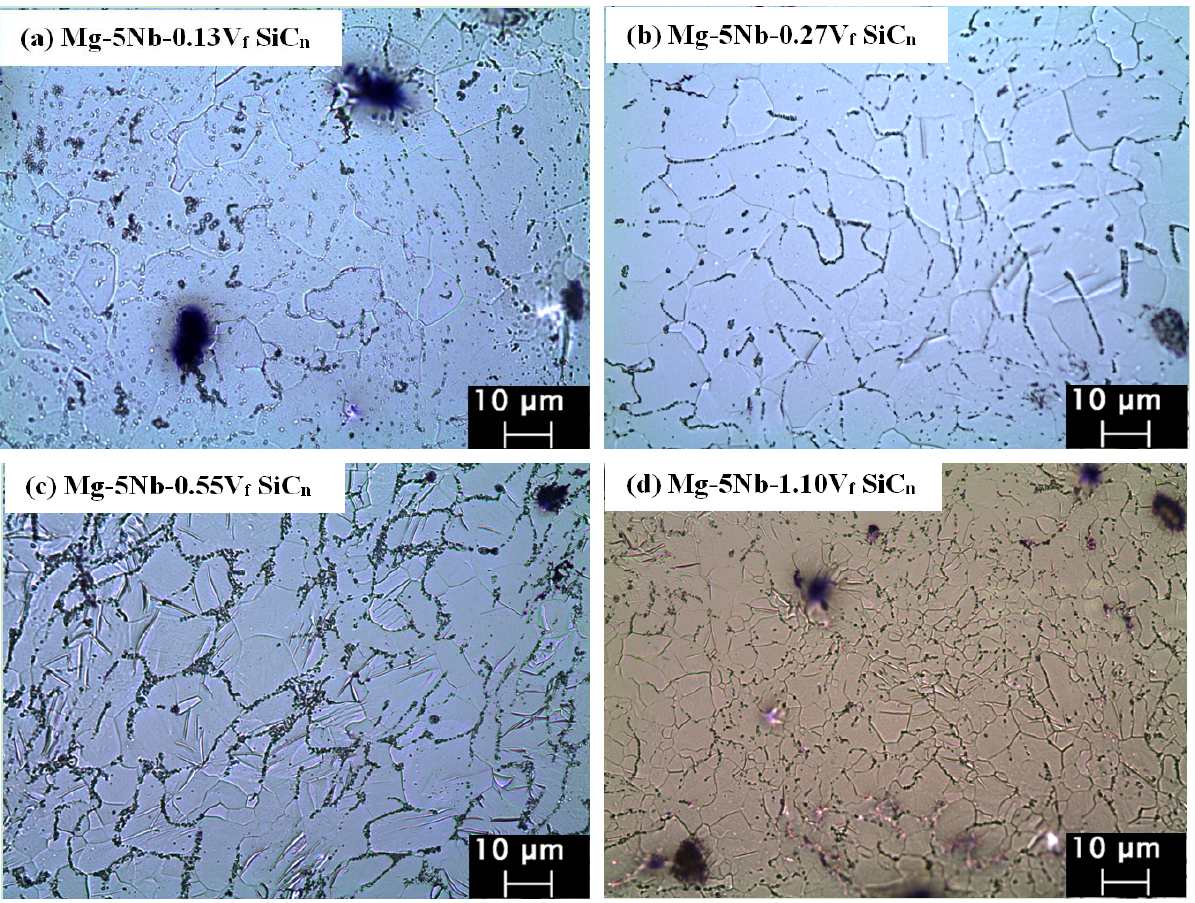
(0.13% V ); ( b ) Mg-5Nb-0.50SiC n f